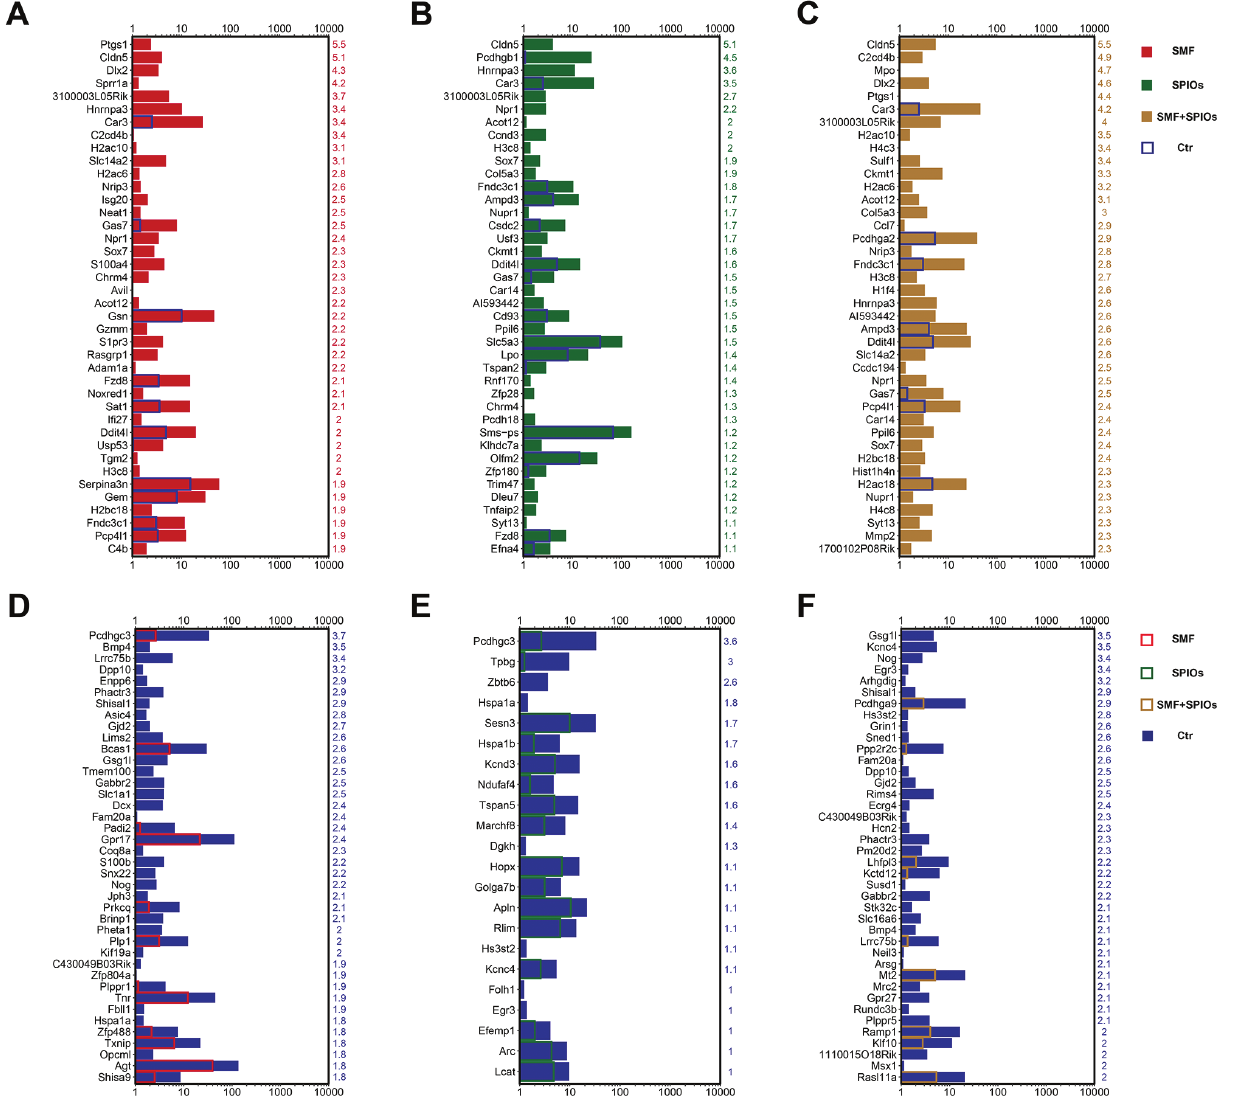
Fig. 3. The differentially expressed genes of NSCs in different experimental groups. The top 40 highly differentially expressed genes of NSCs cultured in the SMF group (A), SPIOs group (B), and the SMF + SPIOs group ranked in descending order (C). The number on the right of each panel represents the fold difference in expression for NSCs in different culture condition groups versus control group. (D-F) The top 40 highly differentially expressed genes of NSCs in the control group ranked in descending order. The number on the right of each panel represents the fold difference in expression for NSCs in the control group versus different culture condition